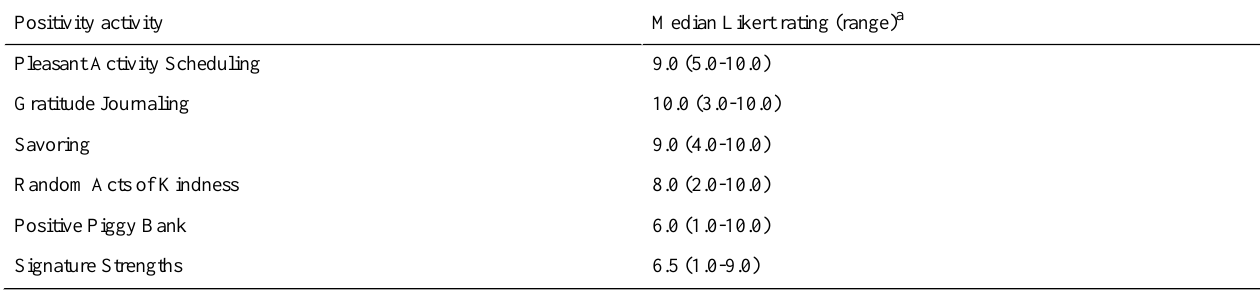
Table 1. Engagement with positive activity